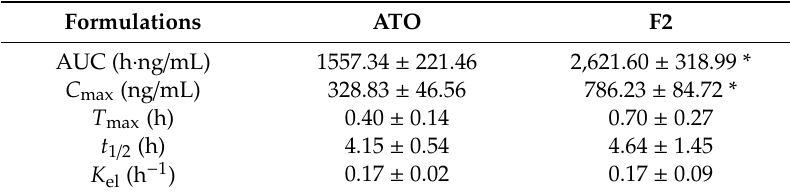
Figure 6. Plasma concentration–time profiles of ATO after oral administration of free drug or solid dispersions in rats. Each value represents the mean ± S.D. ( n = 6). * p < 0.05 compared to free ATO. Table 2. Pharmacokinetic parameters.